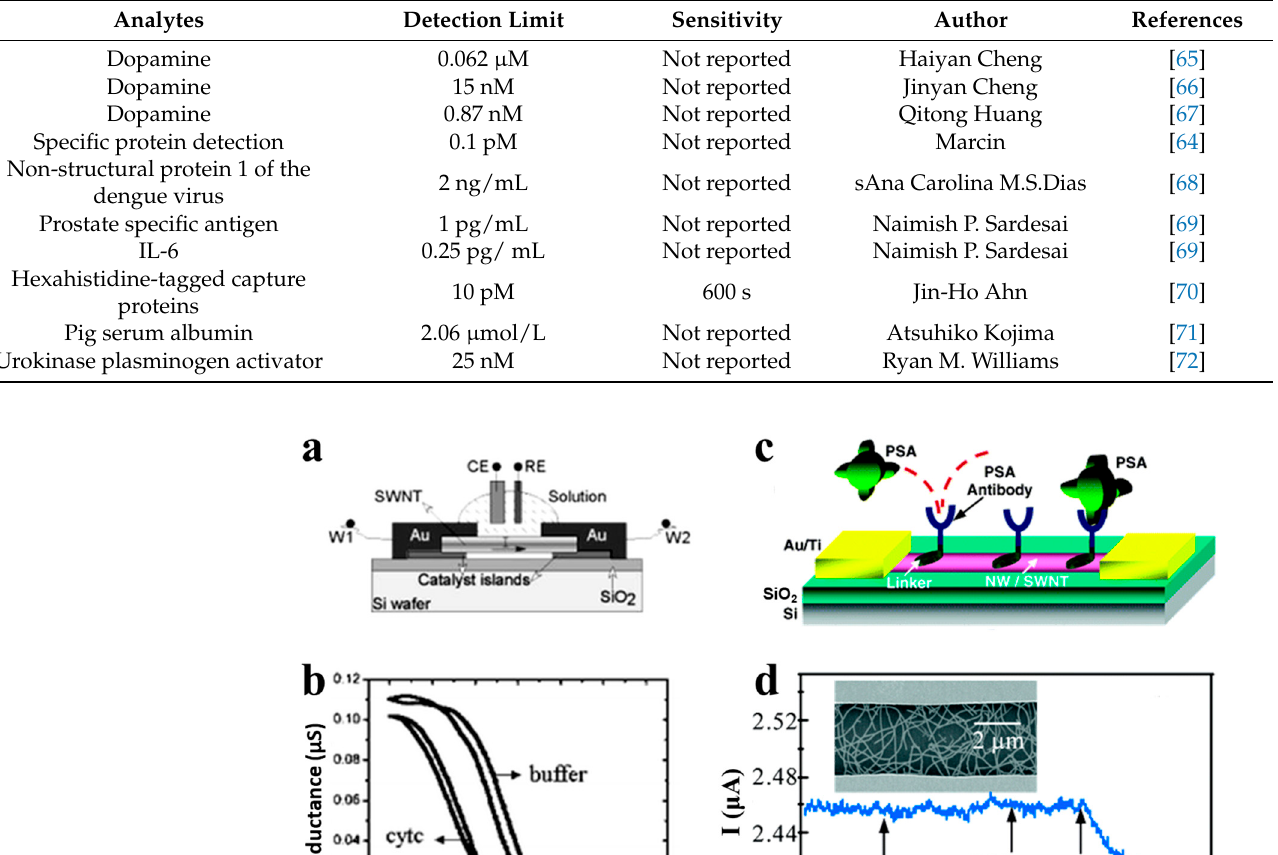
Table 2. The research on CNTFET for protein detection.